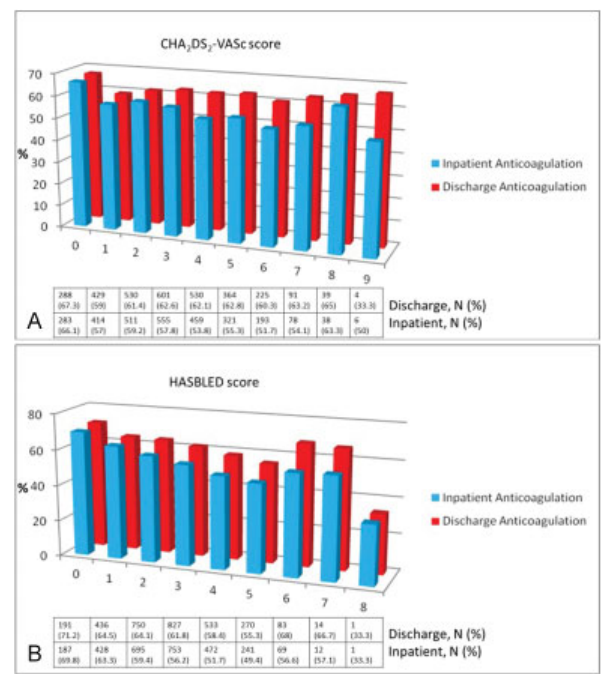
Fig. 2 Frequency (%) of anticoagulation prescription during the inpatient stay and at discharge in patients with atrial fi brillation (AF) by CHA 2 DS 2 -VASc score ( A ). Frequency (%) of anticoagulation pre- scription during the inpatient stay and at discharge in patients with atrial fi brillation (AF) by HAS-BLED score ( B